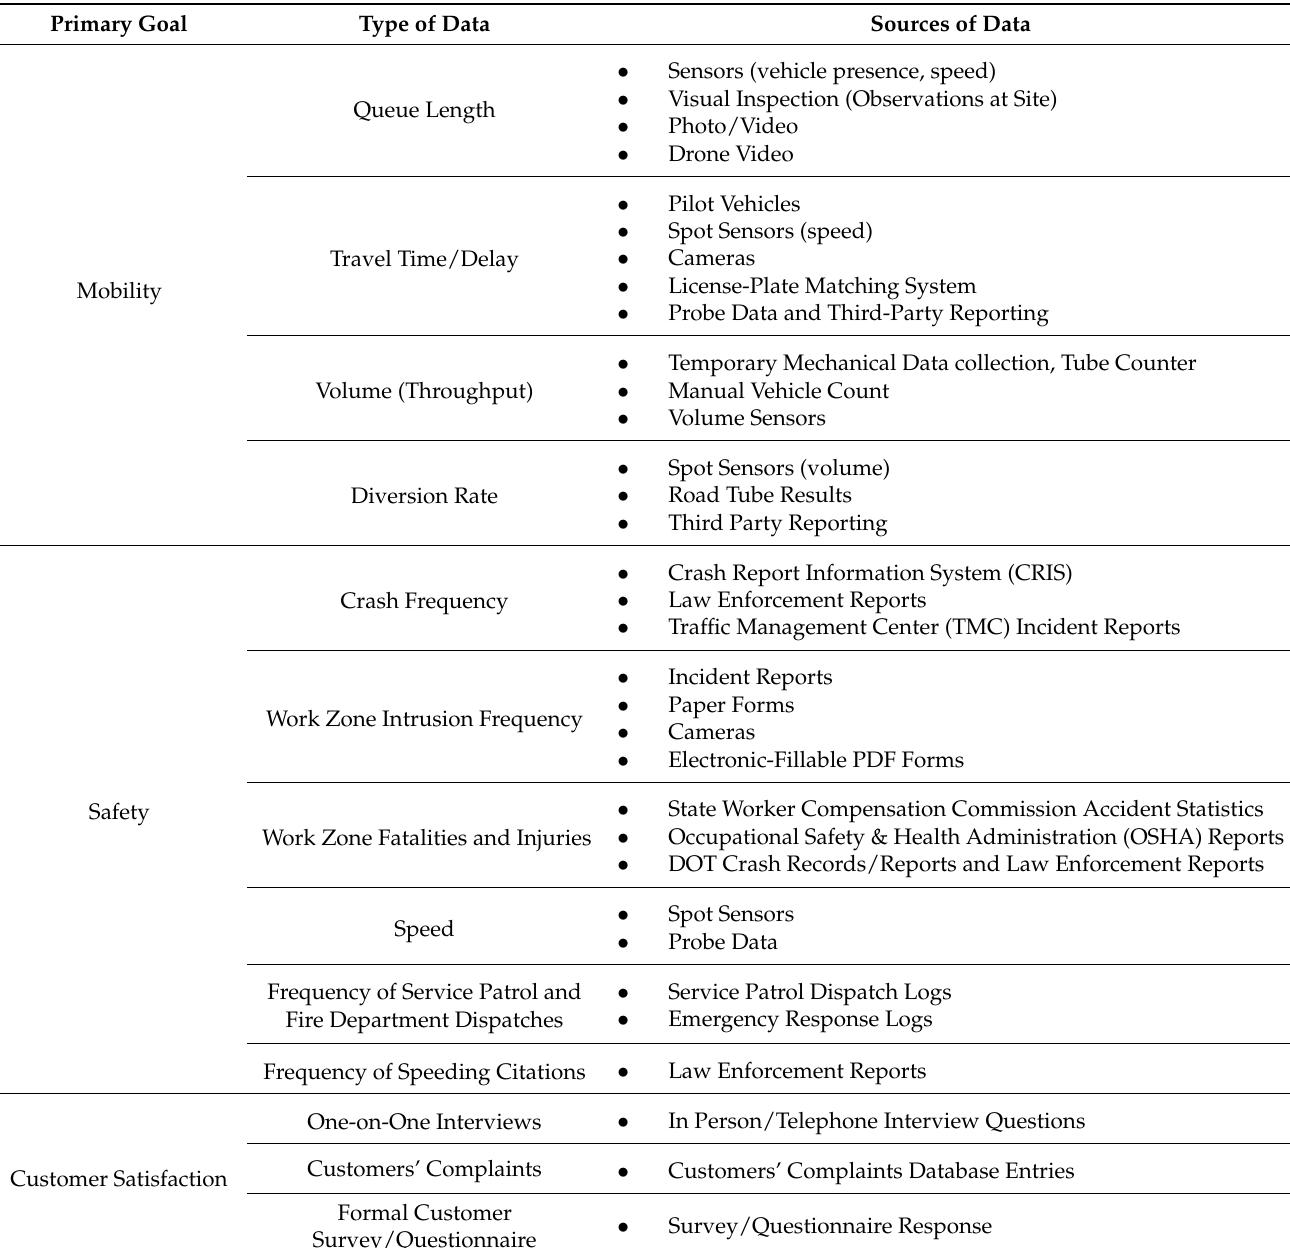
Table 6. Performance measure data and